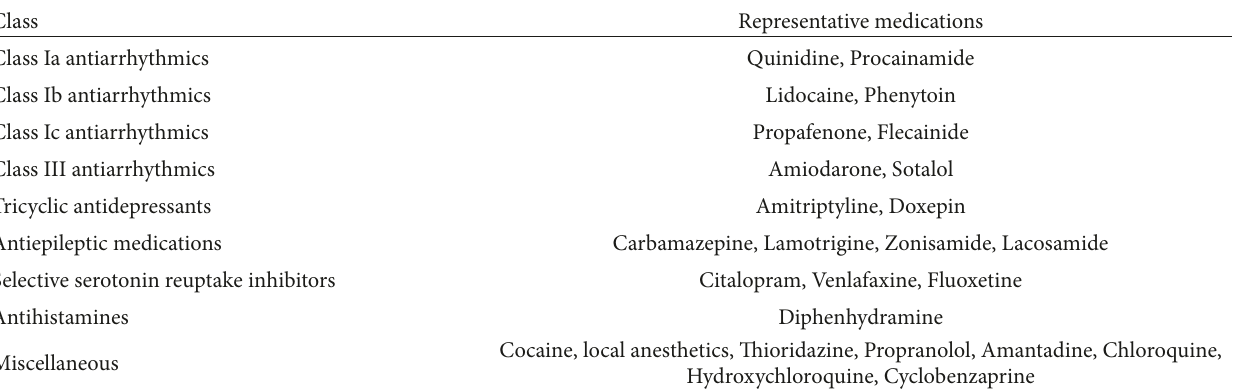
Table 2: List of some drugs with sodium channel blocking